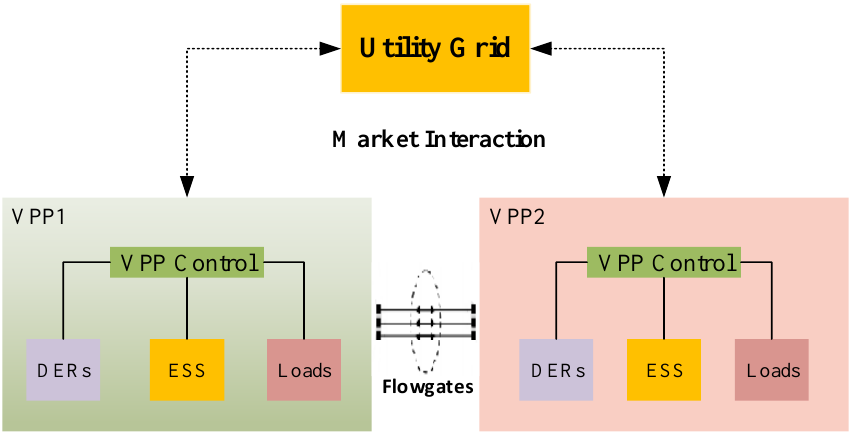
Figure 2. The structure of the interconnected VPPs with the utility grid.